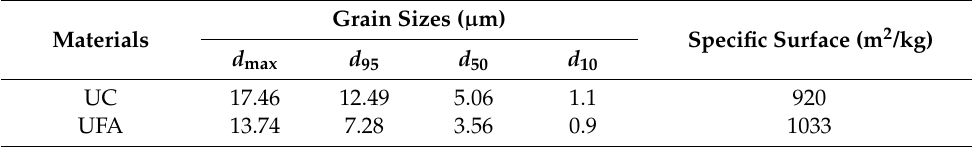
Table 5. Gradation of UC and